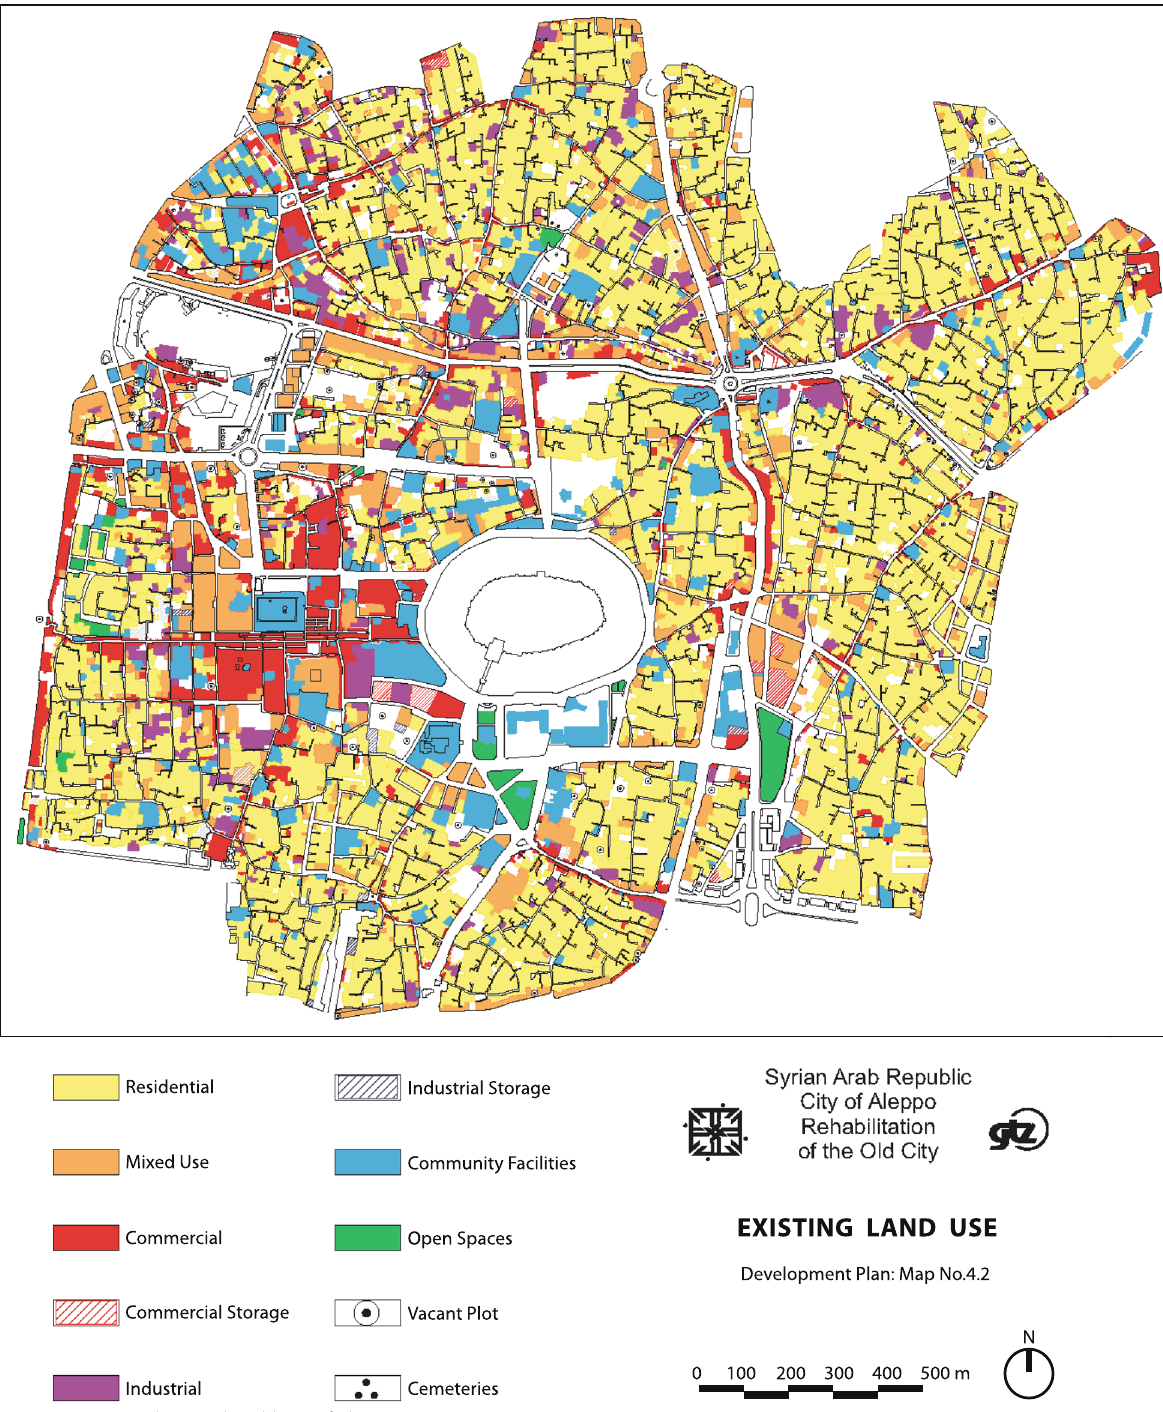
Fig. 9 Existing Land Use in the Old City of Aleppo (Source: GTZ